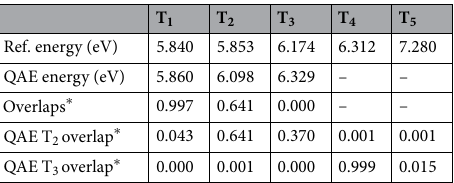
Table 5. Overlap analysis for triplet states of CH 2 Cl 2 . ∗ See text for the description of